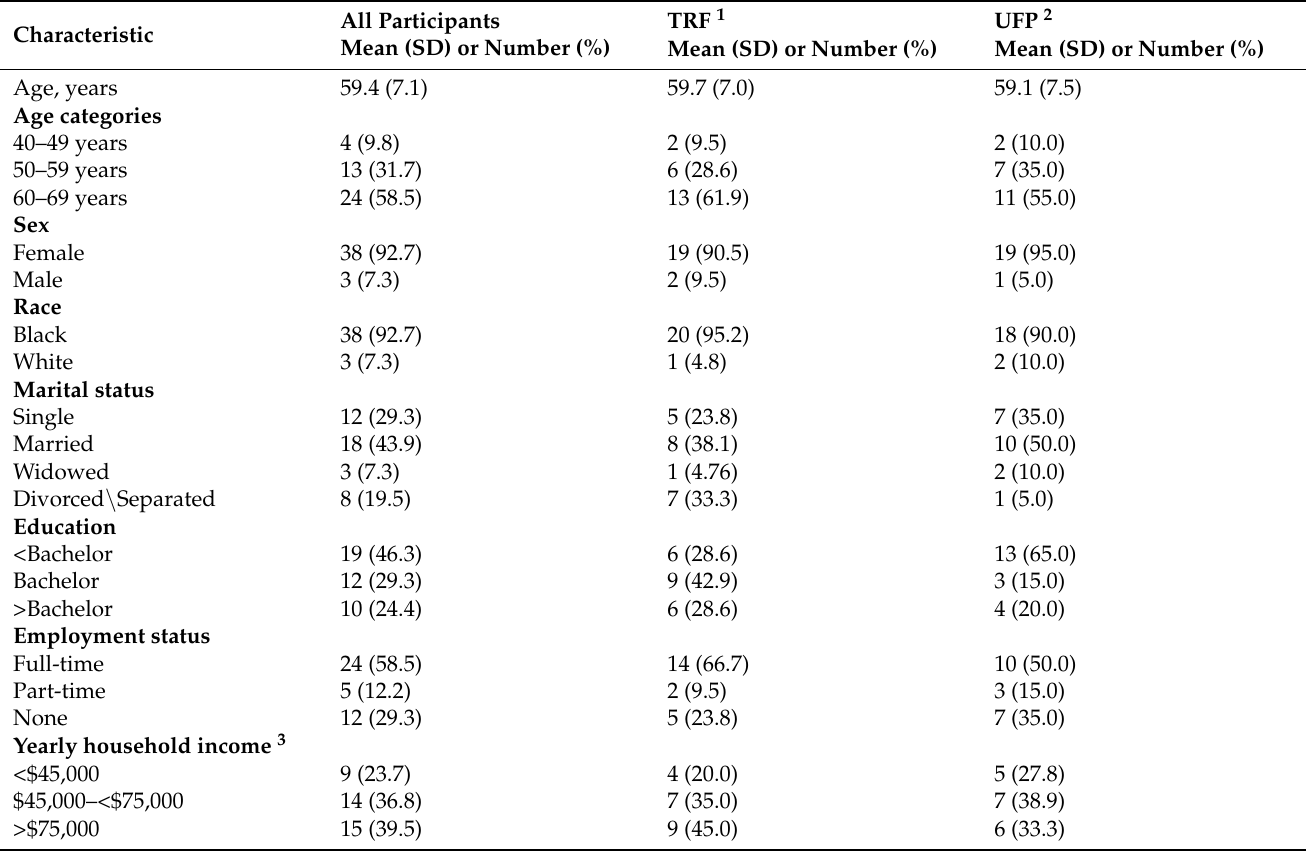
Table 1. Participant baseline characteristics overall and by study